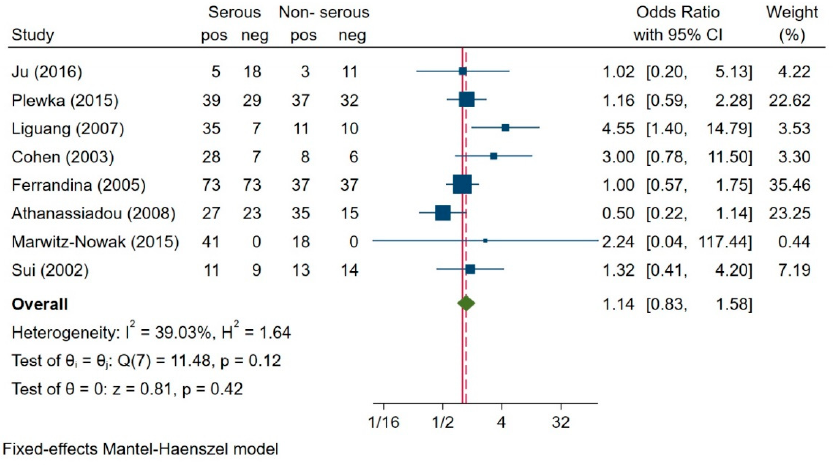
Figure 7. Association between survivin expression and histologic subtype